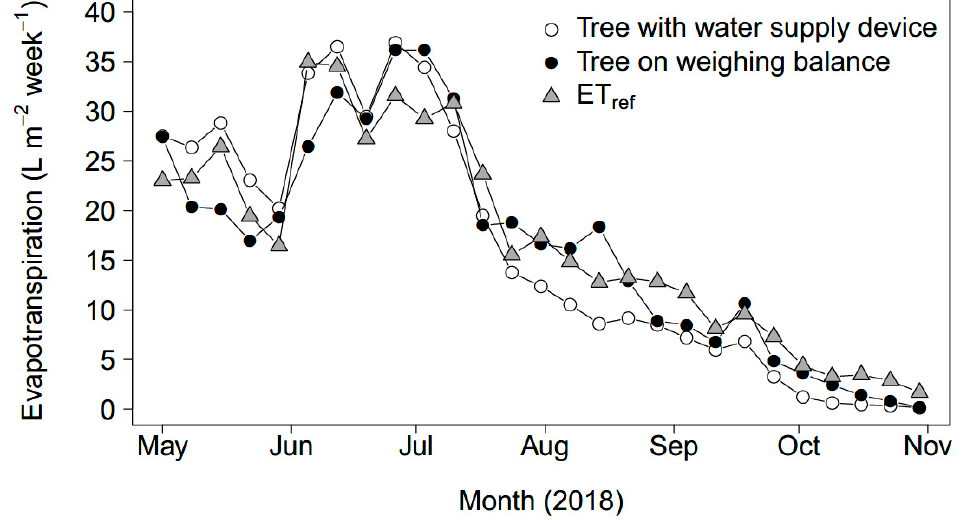
Figure 7. Weekly transpiration of the tree connected to the water supply device (open circles) and the tree on a weighing balance (closed circles). The standardized reference evapotranspiration ET ref is plotted for comparison (triangles).